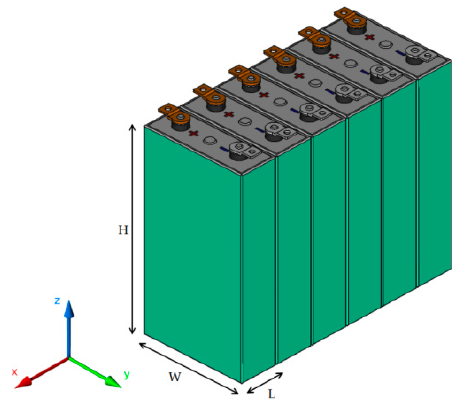
Figure 10. Cells (1 × 6) integration in a module of the battery pack.